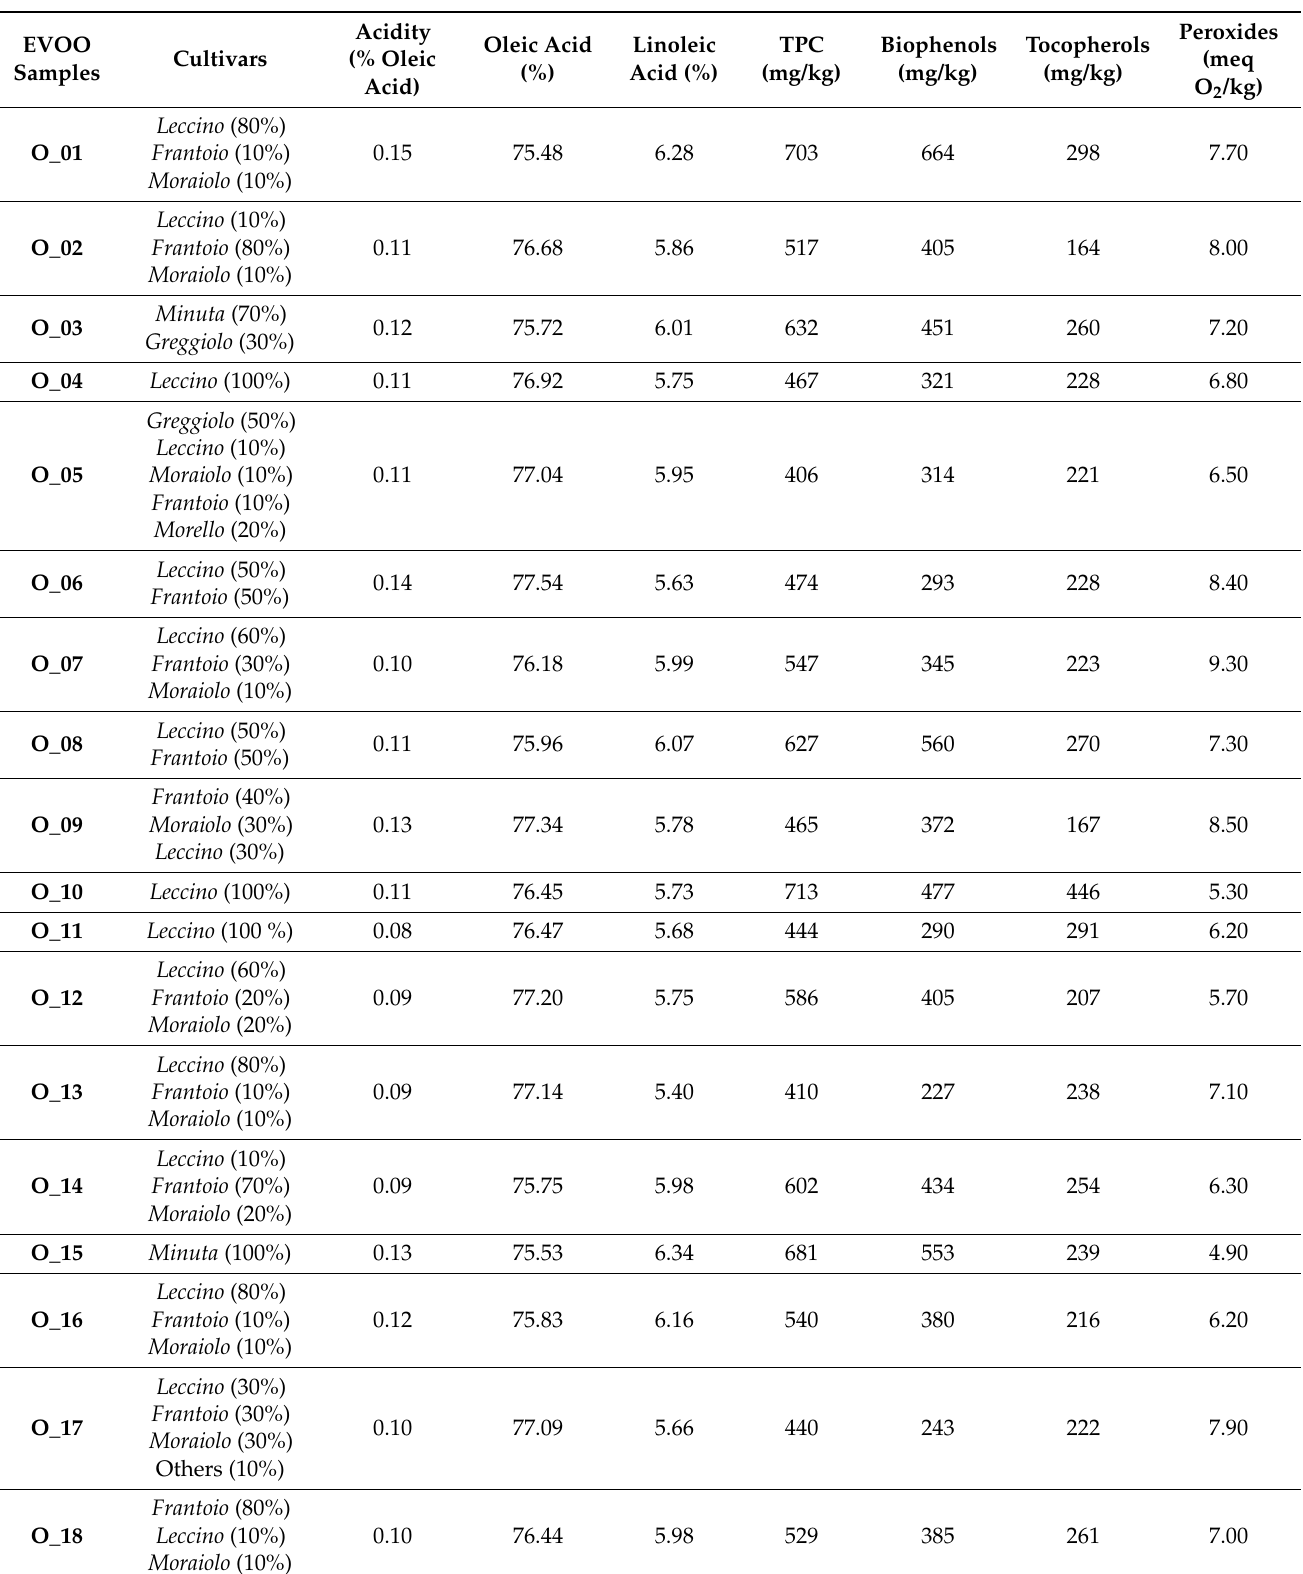
Table 1. Quantification of the main components in EVOO